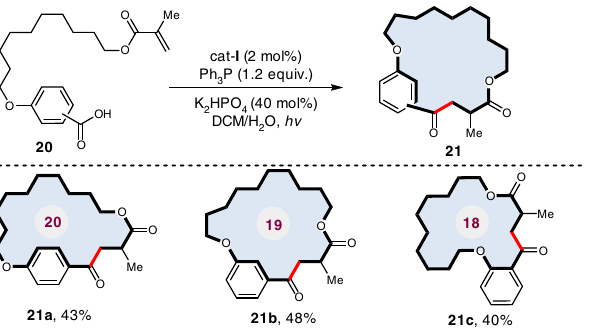
Fig. 6 Deoxygenative macrocyclization in the synthesis of cyclophane- braced cycloketones